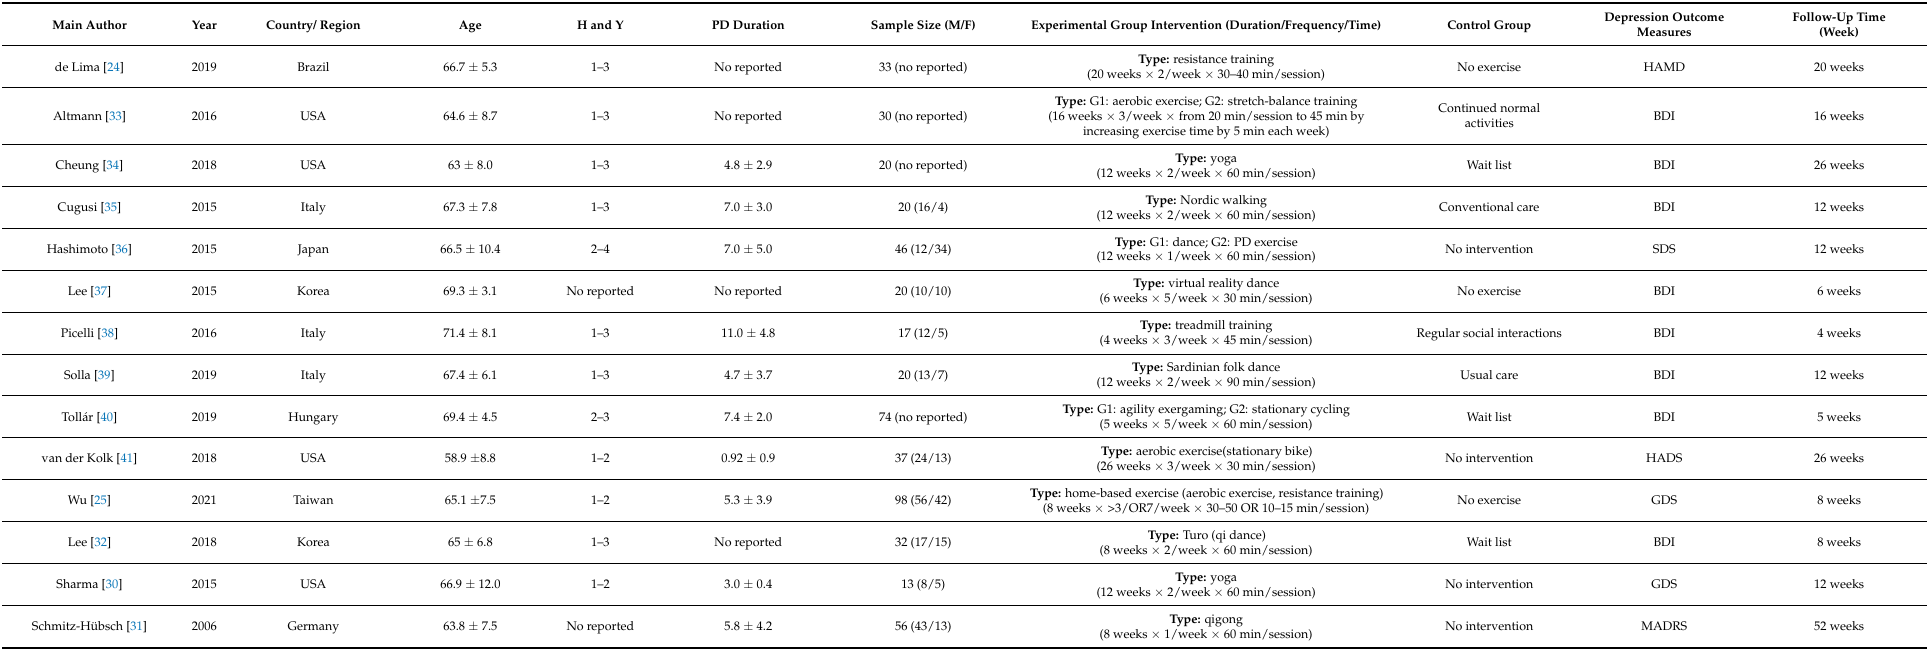
Table 1. Characteristics of the studies included in the